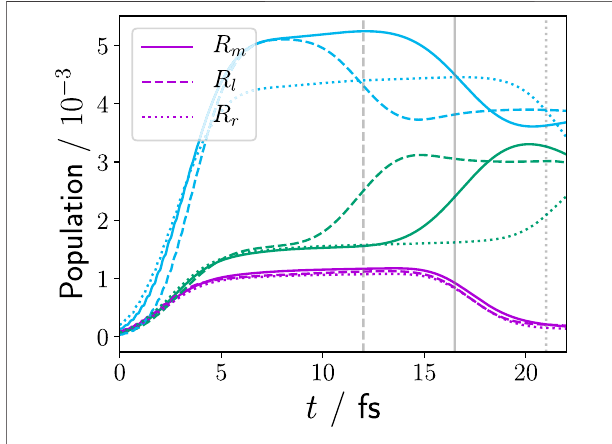
FIGURE 5 | Population of parent ion 1e states using the bwd channel wave function ( Eq. 24 ) to visualise the timing of the non-adiabatic transition between the n = 2 (blue) and n = 1 (green) state for R m (solid lines), R l (dashed lines),and R r (dotted lines).The n =0population(violet)decreasesasthe channel wave function for this ion ground state with corresponding highest photoelectron momenta reaches the absorber after 15 fs. The difference in population of the n = 2 state for R r compared to R m is based on the nuclear wave packet deformation as discussed in the text for the bound/continuum wave